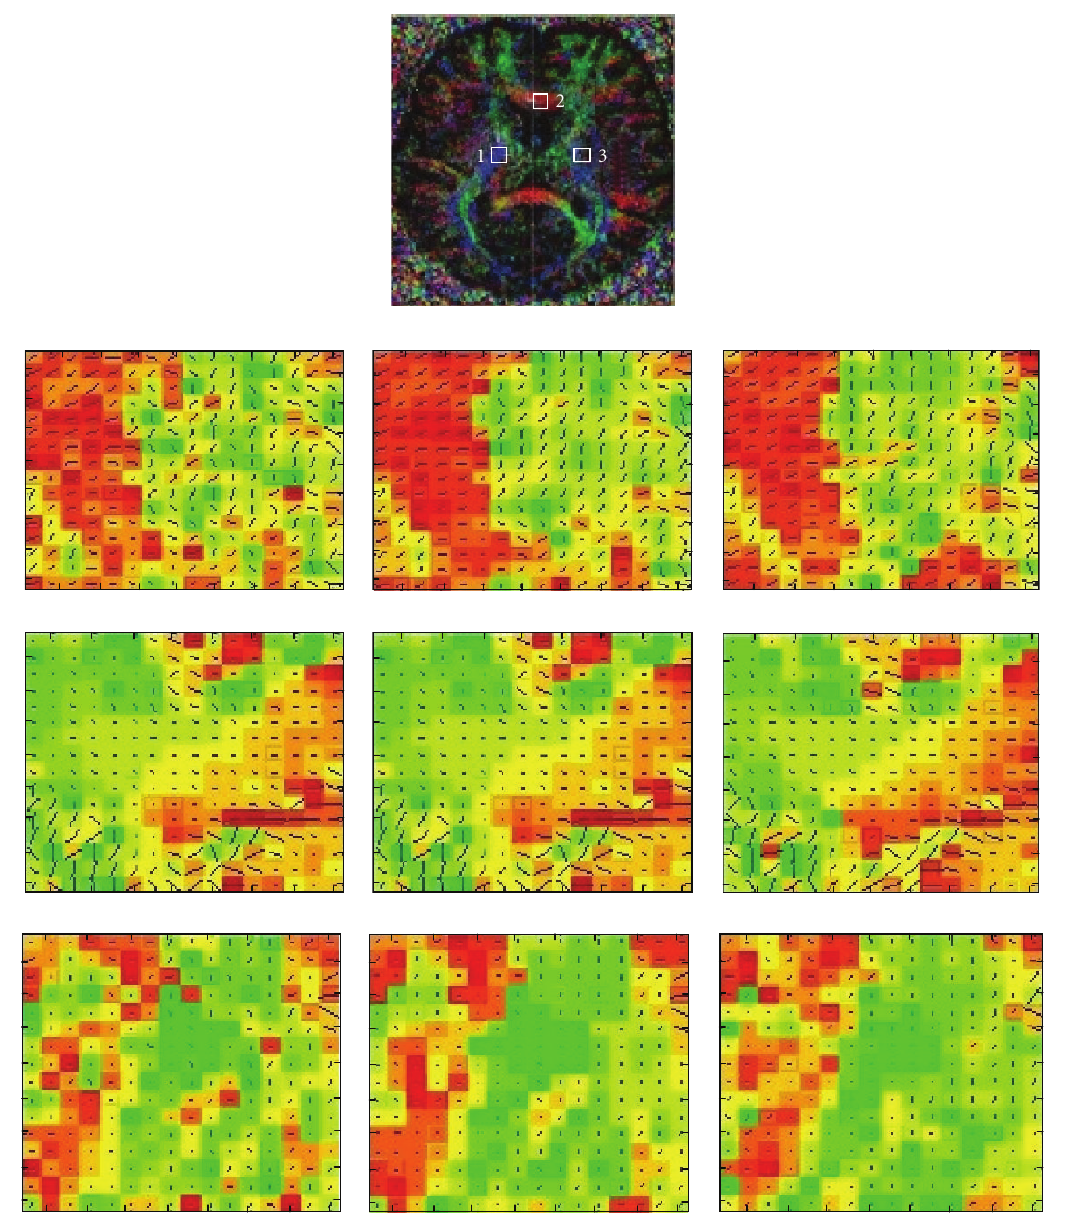
Figure 9: ROI study. Top image shows the ROIs that we use. The second row from left to right: the noisy (4-average) data, denoised data with λ = 13, and clean (18-average) data of ROI 1. The third row from left to right: the noisy (4-average) data, denoised data with λ = 13, and clean (18-average) data of ROI 2. The fourth row from left to right: the noisy (4-average) data, denoised data with λ = 13, and clean (18-average) data of ROI